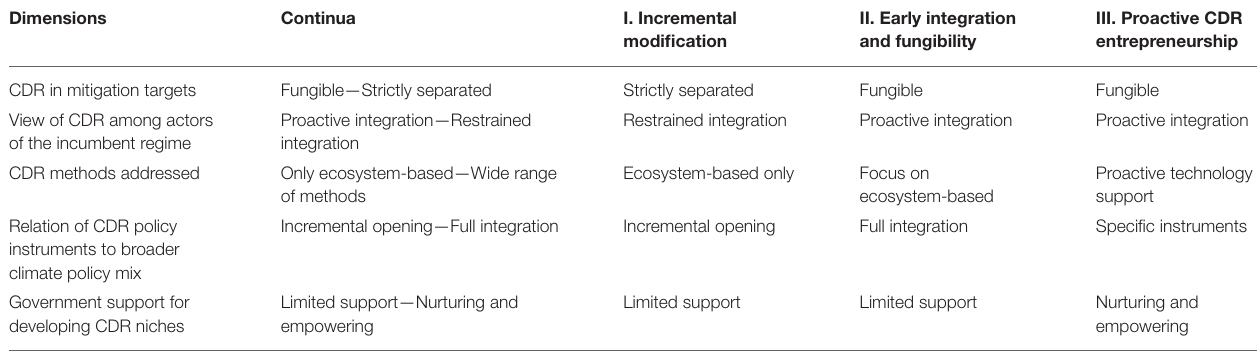
TABLE 2 | Empirically identified dimensions of CDR policymaking and continua of how these dimensions manifest, adapted from Schenuit et al. (2021).